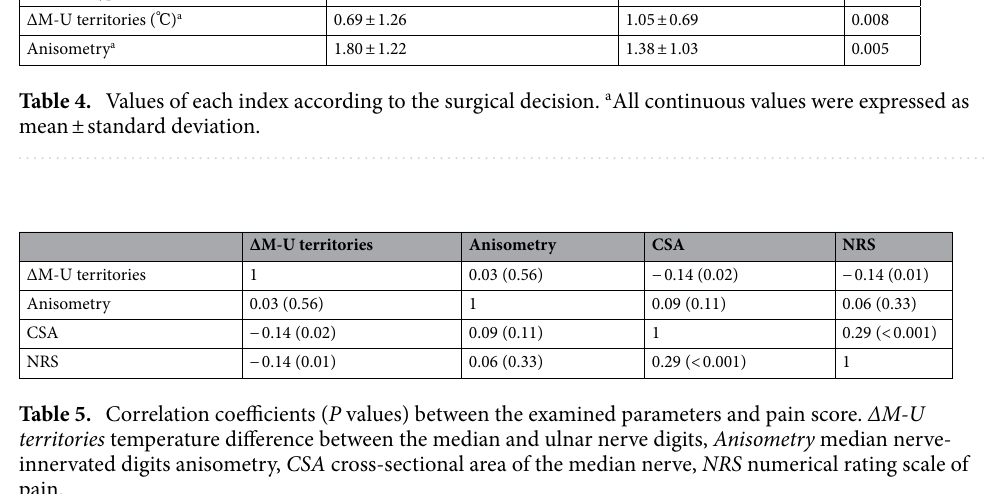
weak negative correlations with CSA ( r = − 0.14; P = 0.02) and the numeric pain scale rating ( r = − 0.14; P = 0.01). No significant correlation between ΔM-U territories and median nerve-innervated digits anisometry was